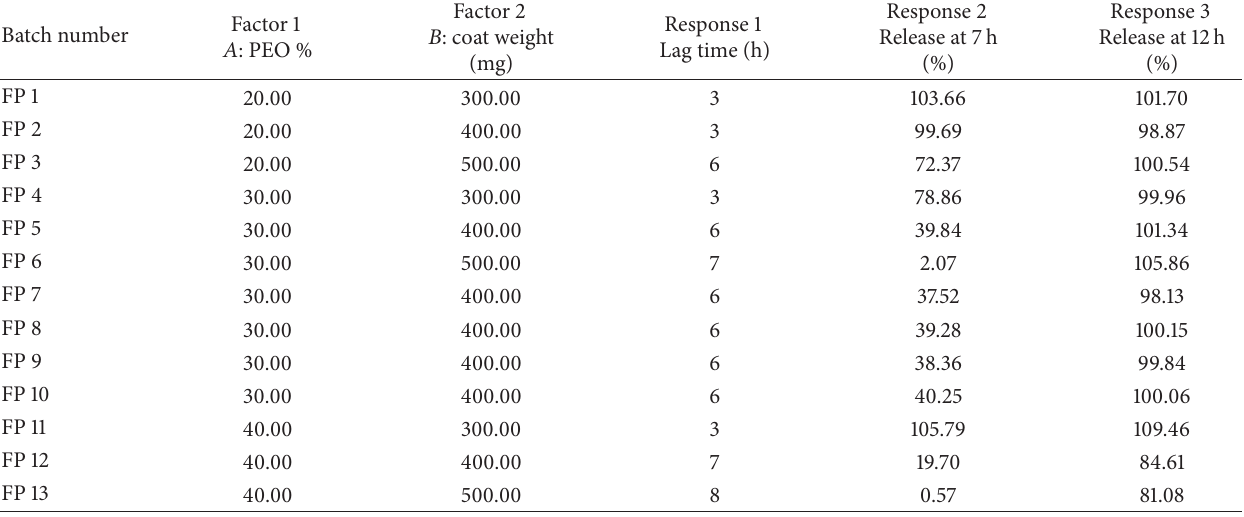
Table 4: Presentation of values and responses in central composite design.